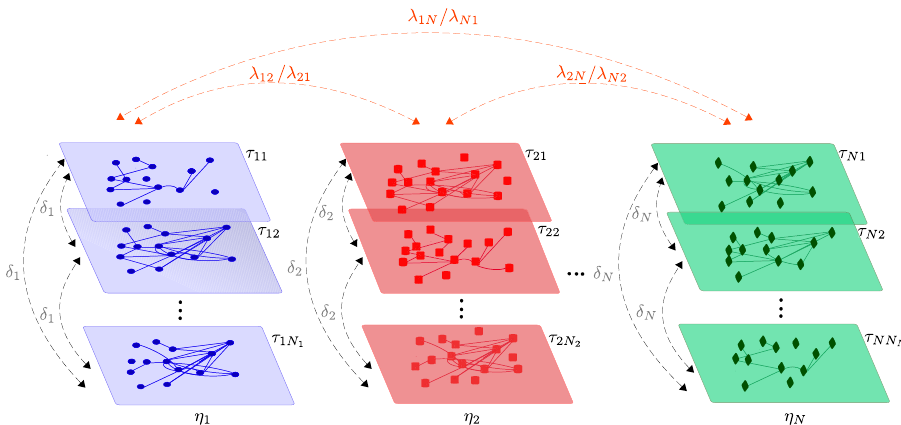
Fig. 2 MultiXrank Random Walk with Restart parameters. Parameters of the Random Walk with Restart allowing to explore universal multilayer networks composed of N multiplex networks (each composed of several layers containing the same set of (replica) nodes but different edges). The parameters δ are associated with the probability to jump from one layer to another in a given multiplex network, λ with the probability to jump from one multiplex network to another multiplex network, τ with the probability to restart in a given layer of a given multiplex network, and η with the probability to restart in a given